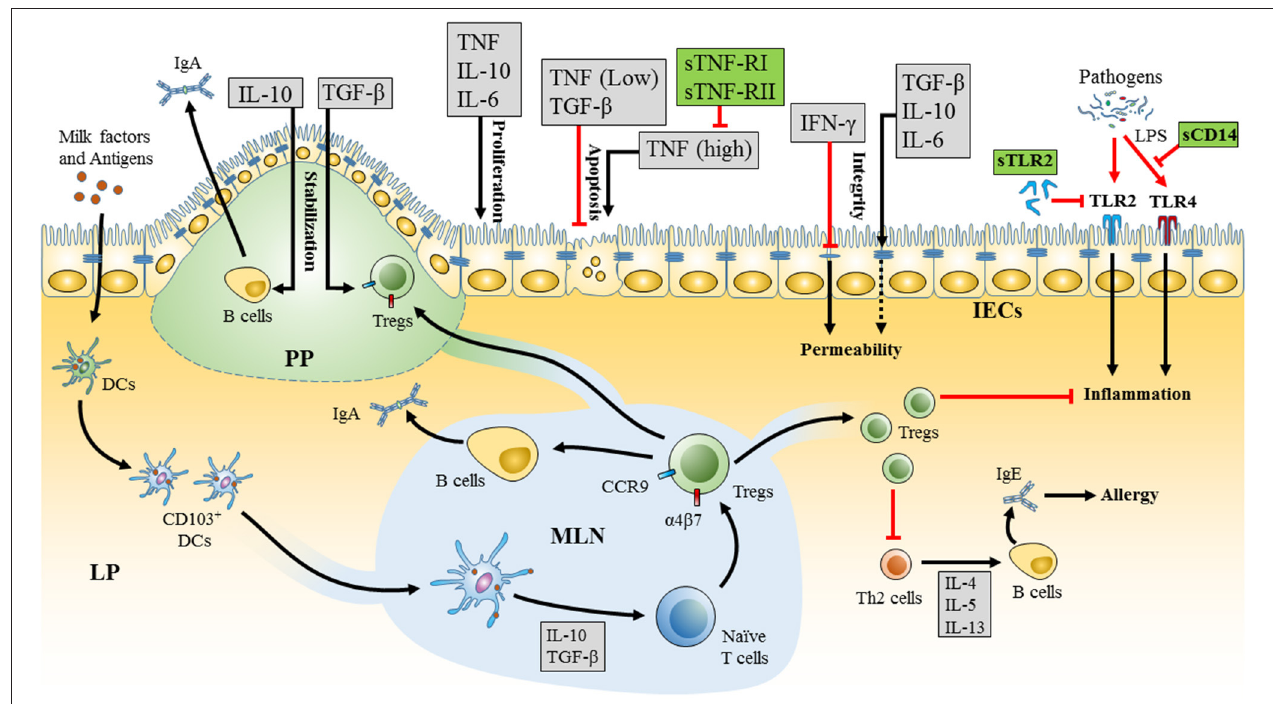
FIGURE 1 | Mechanism of milk cytokines and soluble receptors in promoting oral tolerance in the neonatal intestine. Milk factors enhance the development of tolerogenic dendritic cells (DCs) (CD103 + ) in the neonatal gastrointestinal tract (GIT). These DCs sample milk antigens and migrate to the mesenteric lymph node (MLN). Tolerogenic DCs in the MLN drive the differentiation of naïve T cells into T regulatory cells (Tregs) and the expression of α 4 β 7 integrins and CCR9 receptors that are essential for homing of Tregs to the lamina propria (LP) and Peyer’s patches (PP). Tregs enhance oral tolerance by inhibiting inflammation and T helper 2 (Th2) responses and induce secretion of IgA from B cells. Milk derived cytokines (gray boxes) and soluble receptors (green boxes) form a network of immunomodulators that interact together and impact oral tolerance via a variety of mechanisms. Milk cytokines, including as TGF- β , IL-10, IL-6, TNF, and IFN- γ , affect the integrity, proliferation, and apoptosis of intestinal epithelial cells (IECs). High levels of cytokines in breast milk could also have adverse effects, such as high concentrations of TNF that could be seen in mastitis and induce apoptosis in the IECs. The effects of TNF can be attenuated via the corresponding soluble receptors, sTNF-R-I, and sTNF-R-II that are found in breast milk. Furthermore, soluble toll-like receptor 2 (sTLR2) and soluble CD14 (sCD14) in breast milk can modulate the inflammatory response toward pathogens in the neonate’s GIT by regulating TLR2 and TLR4 mediated cell activation,